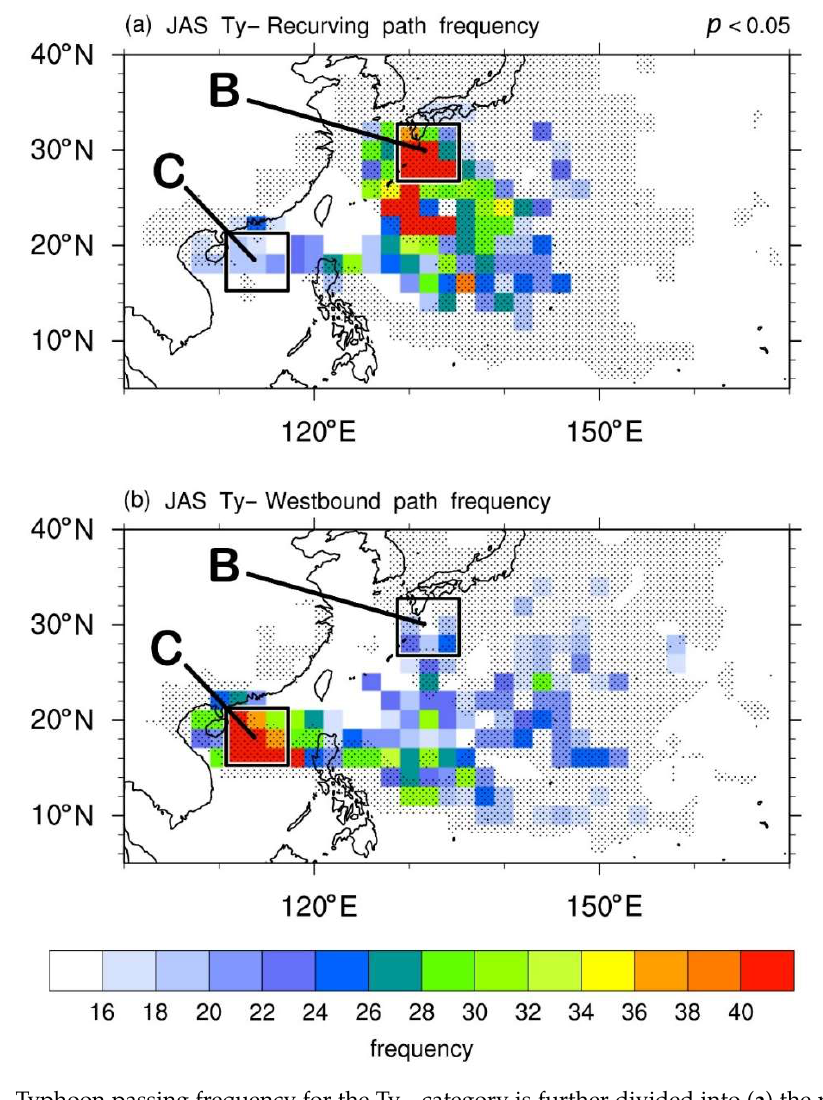
Figure 4. Typhoon passing frequency for the Ty − category is further divided into ( a ) the recurving path and ( b ) the westbound path. The black boxes show the verification domains B and C for typhoon path categorization. The dots denote areas passing a 95% confidence level.